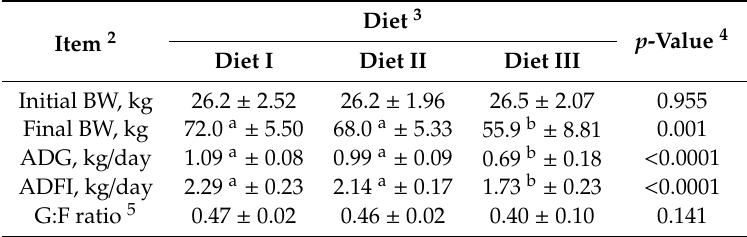
Table 3. The growth performance of the pigs fed with three experimental diets 1 .